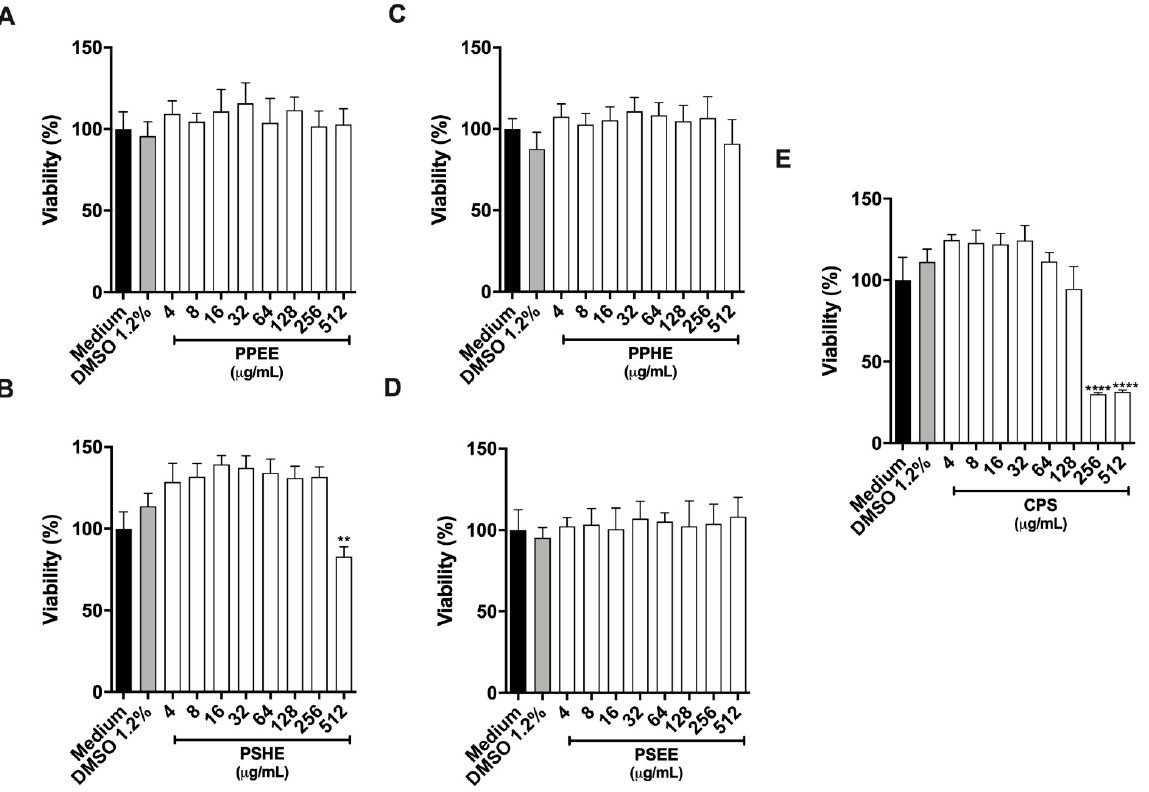
Figure 4. Host cell viability. For 24 h, BeWo cells were treated in twofold serial dilution